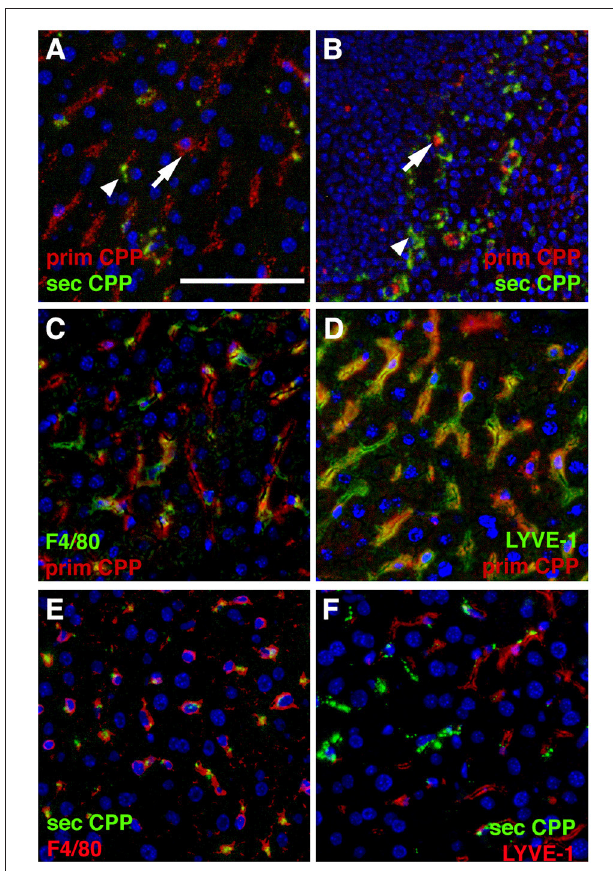
FIGURE 4 | Differential clearance of primary and secondary CPP. Mice were injected with a mixture of fluorescence labeled primary (red) and secondary CPP (green) and the major clearance organs liver (A,C–F) and spleen (B) were harvested 10min after injection, sectioned and analyzed for the presence of CPP. Primary CPP (prim CPP, arrows in A,B ) and secondary CPP (sec CPP, arrow heads in A,B ) showed distinct non-overlapping distribution in liver (A) , and spleen (B) . (C–F) Co-localization with the macrophage-specific marker F4/80 and the liver sinusoidal endothelial LSEC-specific marker LYVE-1 suggested that primary CPP were predominantly cleared by LYVE-1-positive LSEC, and secondary CPP were predominantly cleared by F4/80-positive liver Kupffer cell macrophages. Scale bar: 25 µ